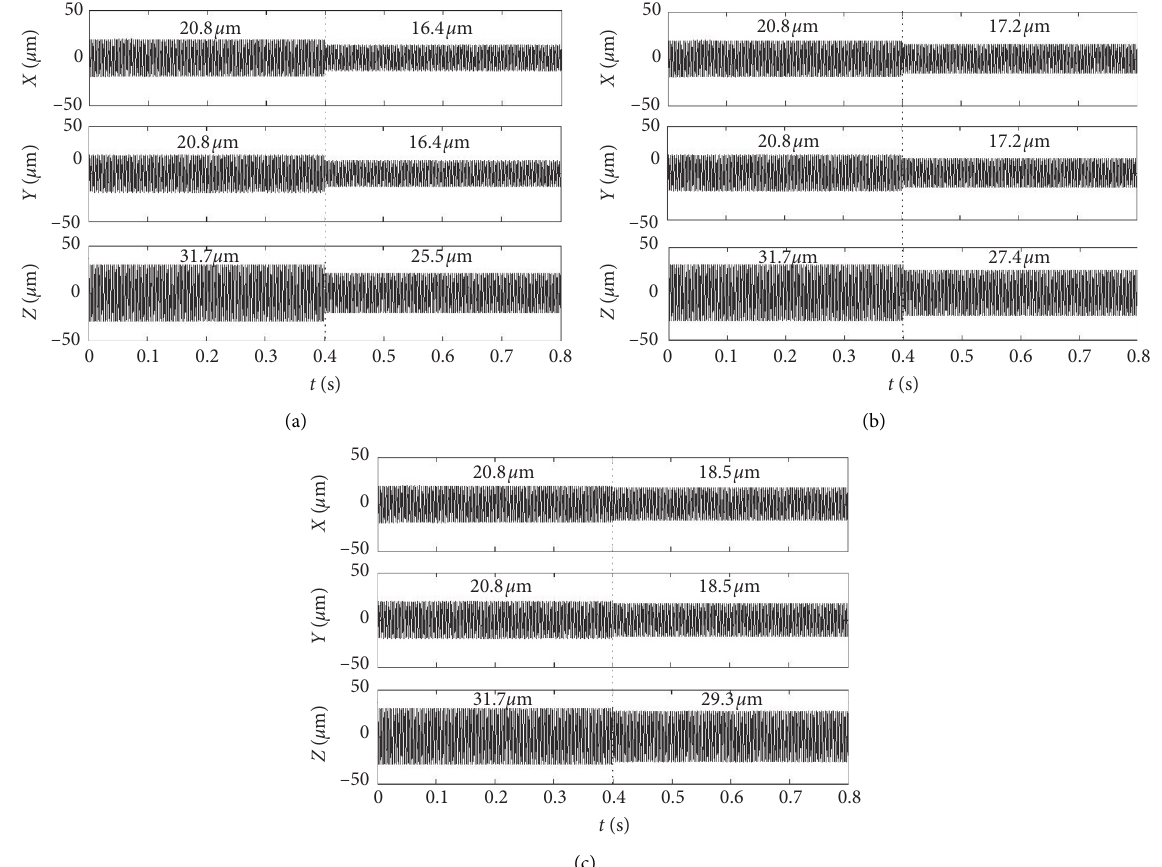
a , F b , (b) deflection torque P d , and